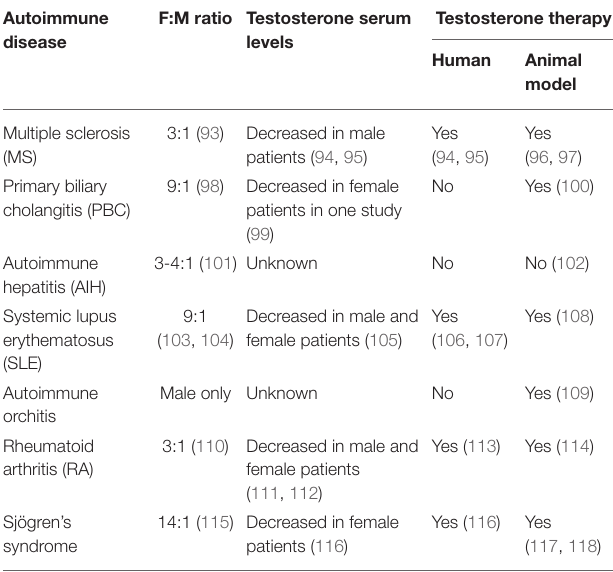
TABLE 1 | Comparison of autoimmune diseases regarding female to male ratio, knowledge on testosterone serum levels, and therapeutic testosterone application. Autoimmune